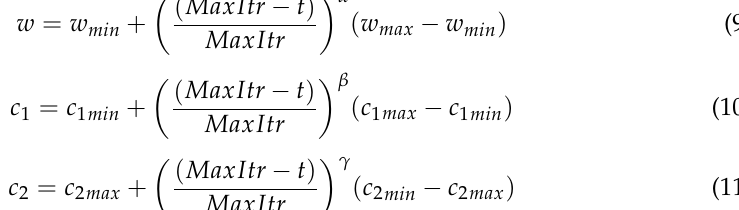
where x t was the best in one particle, and x t PB